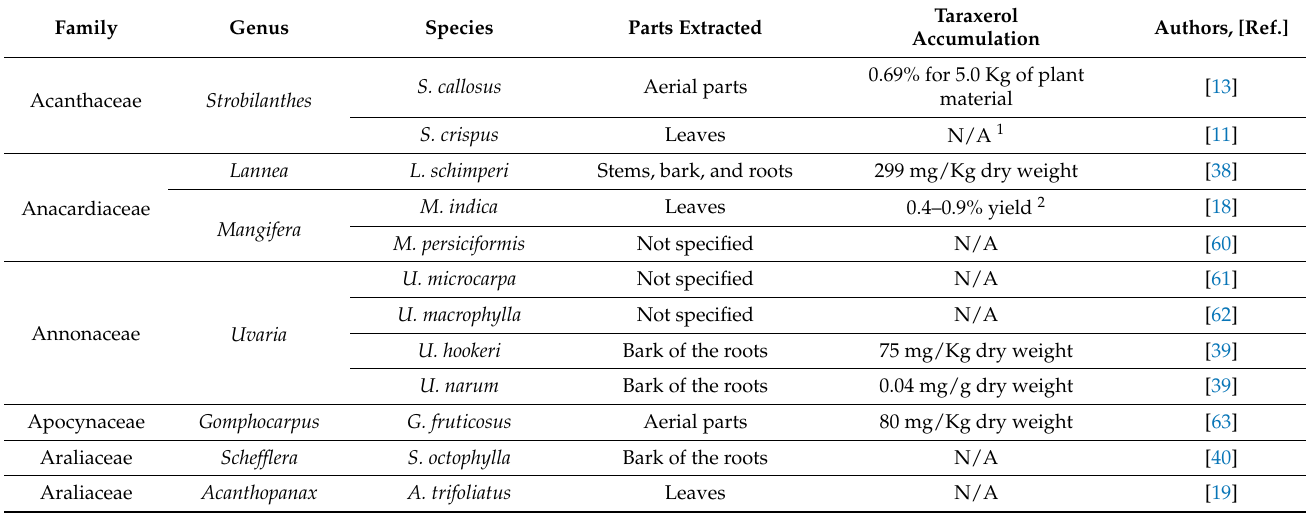
Table 1. The distribution of taraxerol isolated from different plant taxa.